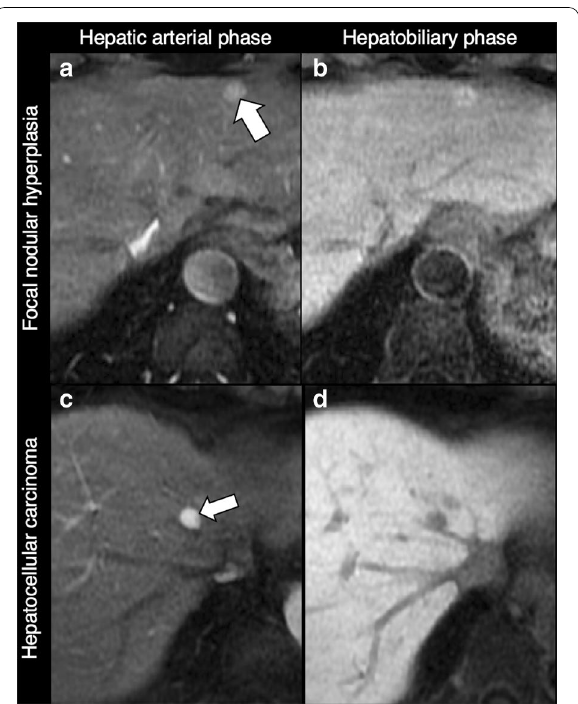
Fig. 9 Differential diagnosis of hypervascular lesions in the arterial phase in oncologic patients. Top row: 53‑year‑old woman with breast cancer and focal nodular hyperplasia. Gadobenate dimeglumine‑enhanced MRI demonstrates a focal nodular hyperplasia (arrow) that ( a ) enhances in the hepatic arterial phase and ( b ) is hyperintense in the hepatobiliary phase. Bottom row: carcinoma. Gadoxetate disodium‑enhanced MRI demonstrates a small HCC nodule (arrow) that ( c ) enhances in the hepatic arterial phase and ( d ) is hypointense in the hepatobiliary